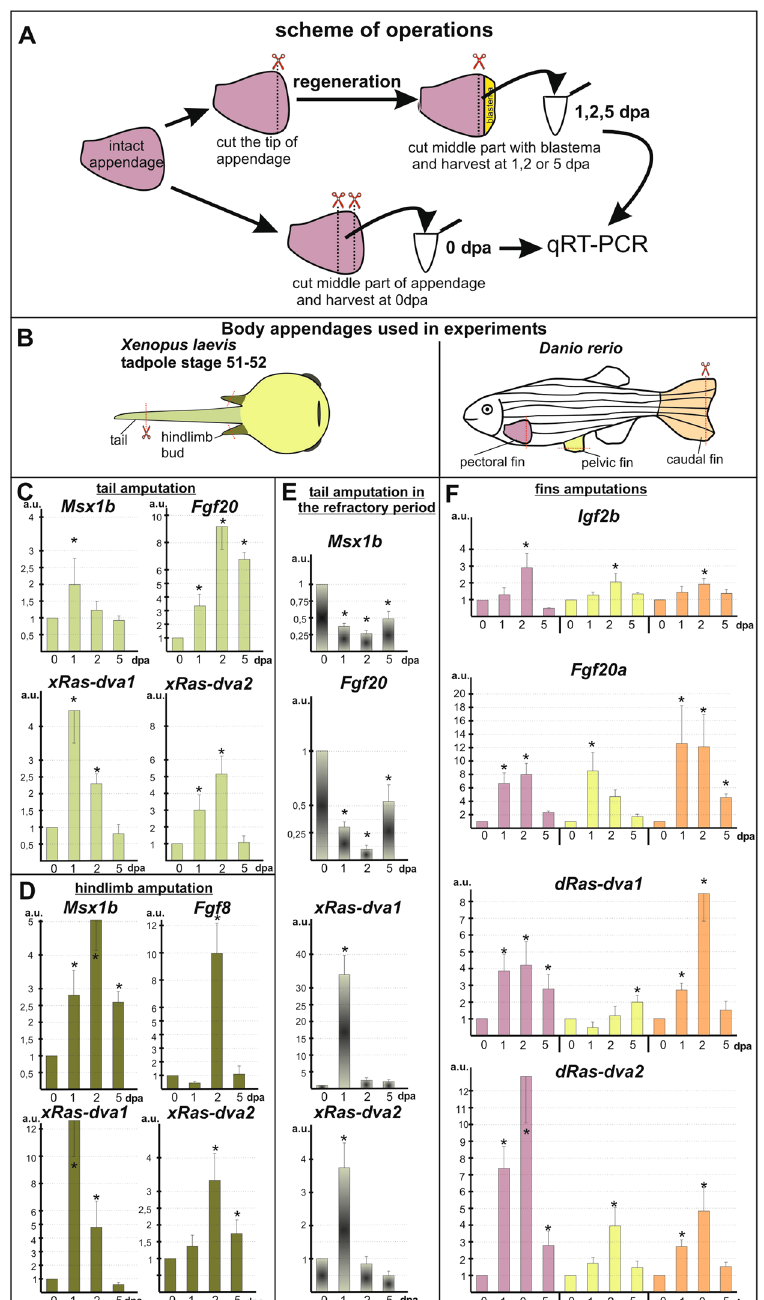
Figure 2. The qRT-PCR analysis of Ras-dva1 , Ras-dva2 and regeneration markers expression in X. laevis tadpoles and D. rerio adult fishes after the body appendages amputation. ( A , B ) Schemes of experiments. Drawings were done by M.B.T. ( C , D ) The results of qRT-PCR analysis of xRas-dva1 , xRas-dva2 and marker genes ( Msx1b, Fgf20 or Fgf8 ) expression dynamics during X. laevis tadpole (stage 51) tail ( C ) or hindlimb bud ( D ) regeneration at 0, 1, 2, 5 dpa (days post amputation). The geometric mean of expression of two reference housekeeping genes: ornithine decarboxylase (ODC) and elongation factor 1alpa (EF-1alpha) was used for normalization of the target genes expression levels. ( E ) The expression of xRas-dva genes and regeneration marker genes in tadpole tails amputated in the refractory period (stage 46) at 1, 2, 5 dpa in comparison to 0 dpa. ( F ) qRT-PCR analysis of dRas-dva1, dRas-dva2 genes and Fgf20a , Igf2b markers expression pattern during the D. rerio fins regeneration on 1, 2 5 dpa in comparison to 0 dpa (the color of the fin on B correspond to the color of columns representing the gene expression in respective fin on F ). All graphs represent means of quantification using total RNA derived from three independent samples. The value of normalized PCR signal in the 0 dpa sample, harvested immediately after amputation, was taken as an arbitrary unit (a.u.) in each series. Data are represented as mean ± SD, t-test, p < 0,05